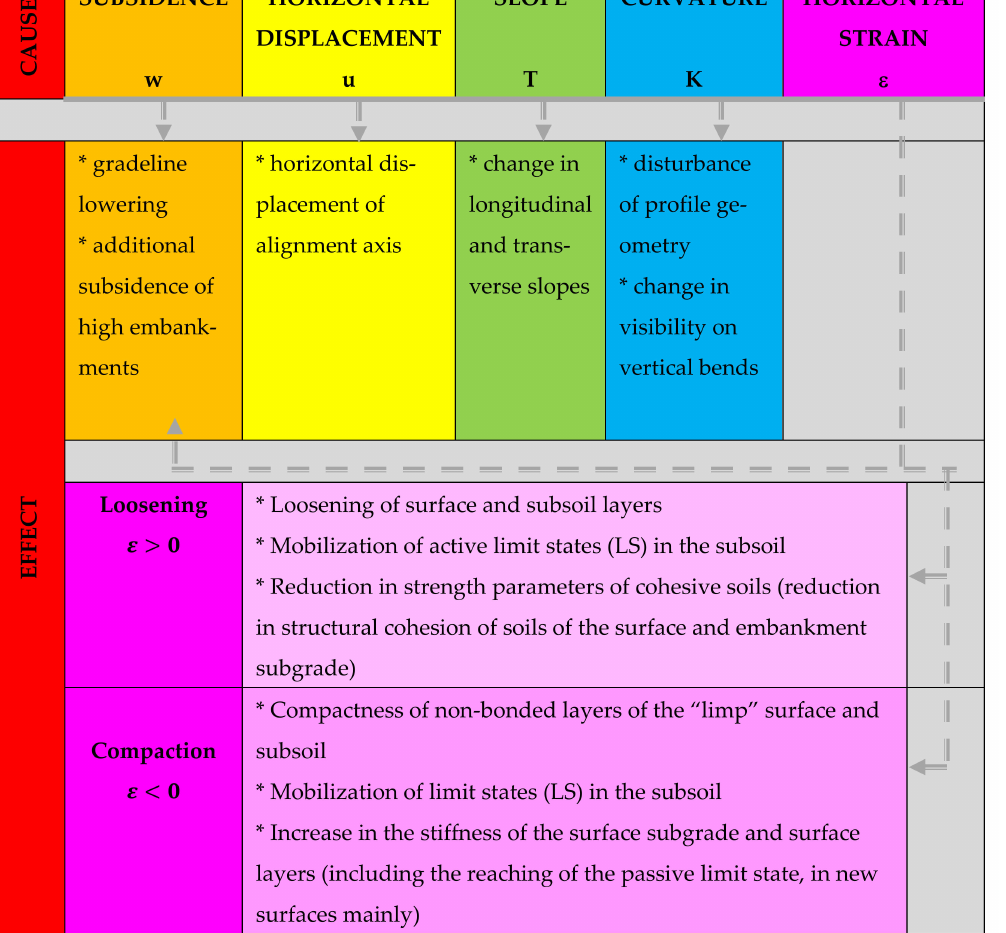
Figure 3. Cause-and-effect relationship describing the impact of indicators of the mining area continuous deformation on functional and strength parameters of the road